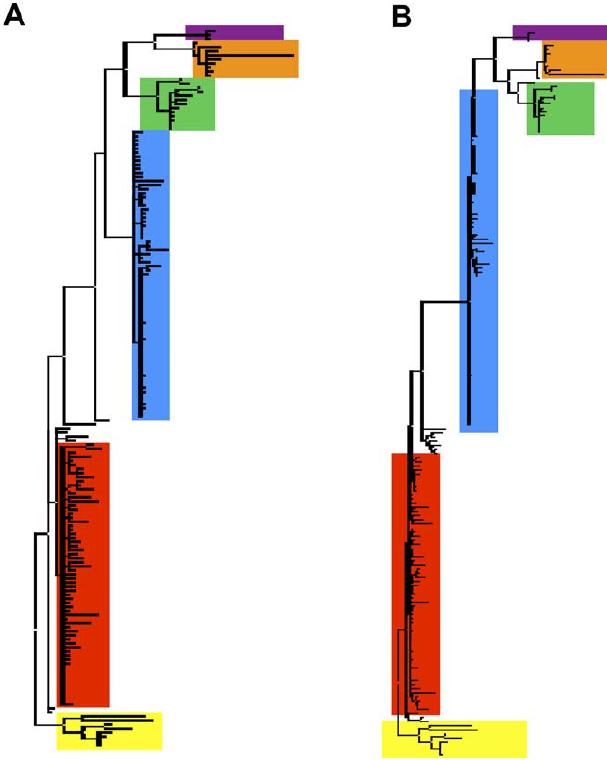
Figure 2. Phylogenic Reconstruction of the GII.4 Capsid Sequence A multiple alignment was generated using 176 full length capsid amino acid sequences and trees were generated using BI and MP analysis. The clusters are marked as follows: yellow, sequences from Camberwell cluster; red, sequences from Grimsby cluster; blue, sequences from the Farmington Hills cluster; green, sequences from the Hunter cluster; orange, sequences from the Sakai cluster; and purple, sequences from the Den Haag cluster. The trees are drawn to similar scales and are rooted with the earliest Camberwell cluster. (A) BI predicts that Camberwell gave rise to Grimsby, which gave rise to an LCA from which Farmington Hills and a LCA for the three extant clusters evolved independently (for full tree see Figure S2). (B) The MP bootstrapped tree generated by MEGA 4.0 was similar to the Bayesian tree with the exception that the Grimsby cluster gave rise to the Farmington Hills cluster, and a LCA of all extant clusters arose from Farmington Hills (for full tree see Figure S3). A MP tree generated by PAUP 4.0b10 predicted similar results (Figure